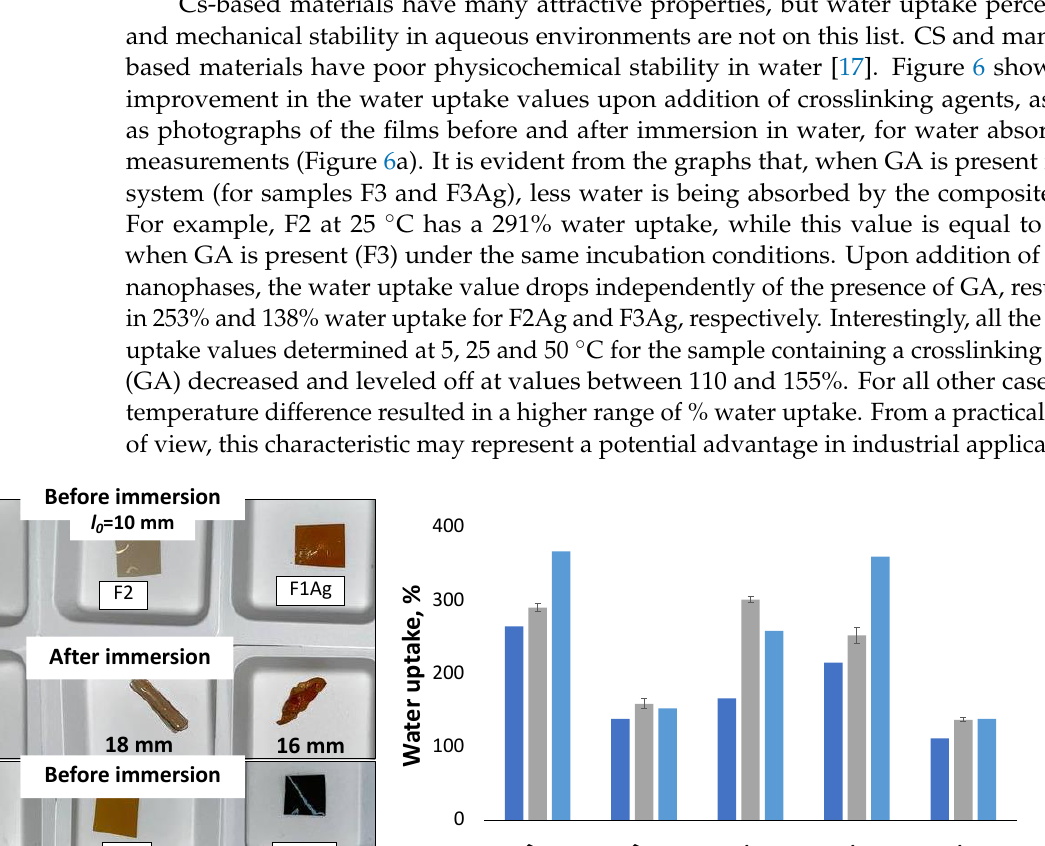
view, this gives the potential advantage for the industrial application.